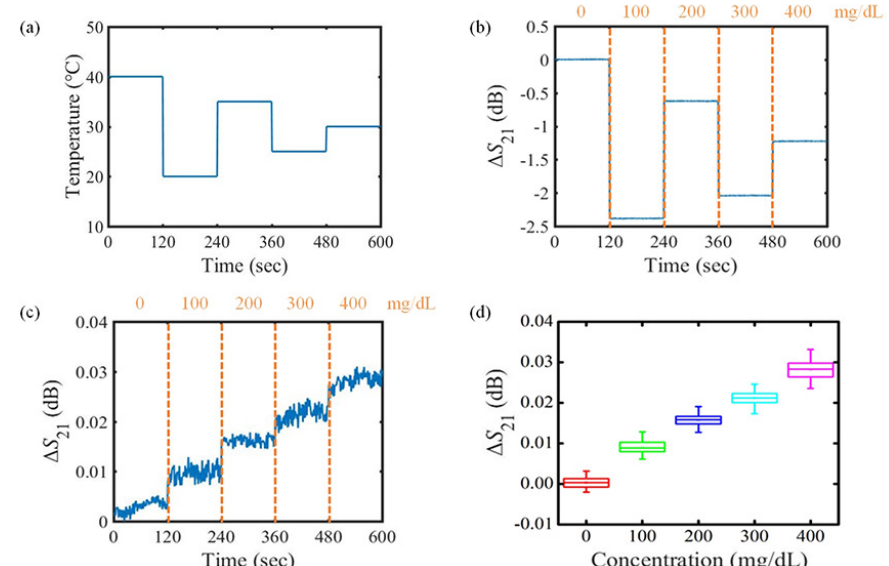
Figure 8. Measured results of variation in the transmission coefficient for varying temperature condition. ( a ) temperature set arbitrarily to address both room temperature (20 ◦ C) and body temperature (36 ◦ C); ( b ) variation in transmission coefficient before the temperature correction; ( c ) variation in transmission coefficient after the temperature correction; ( d ) statistical result for variation in the transmission coefficient after temperature correction obtained from repeated